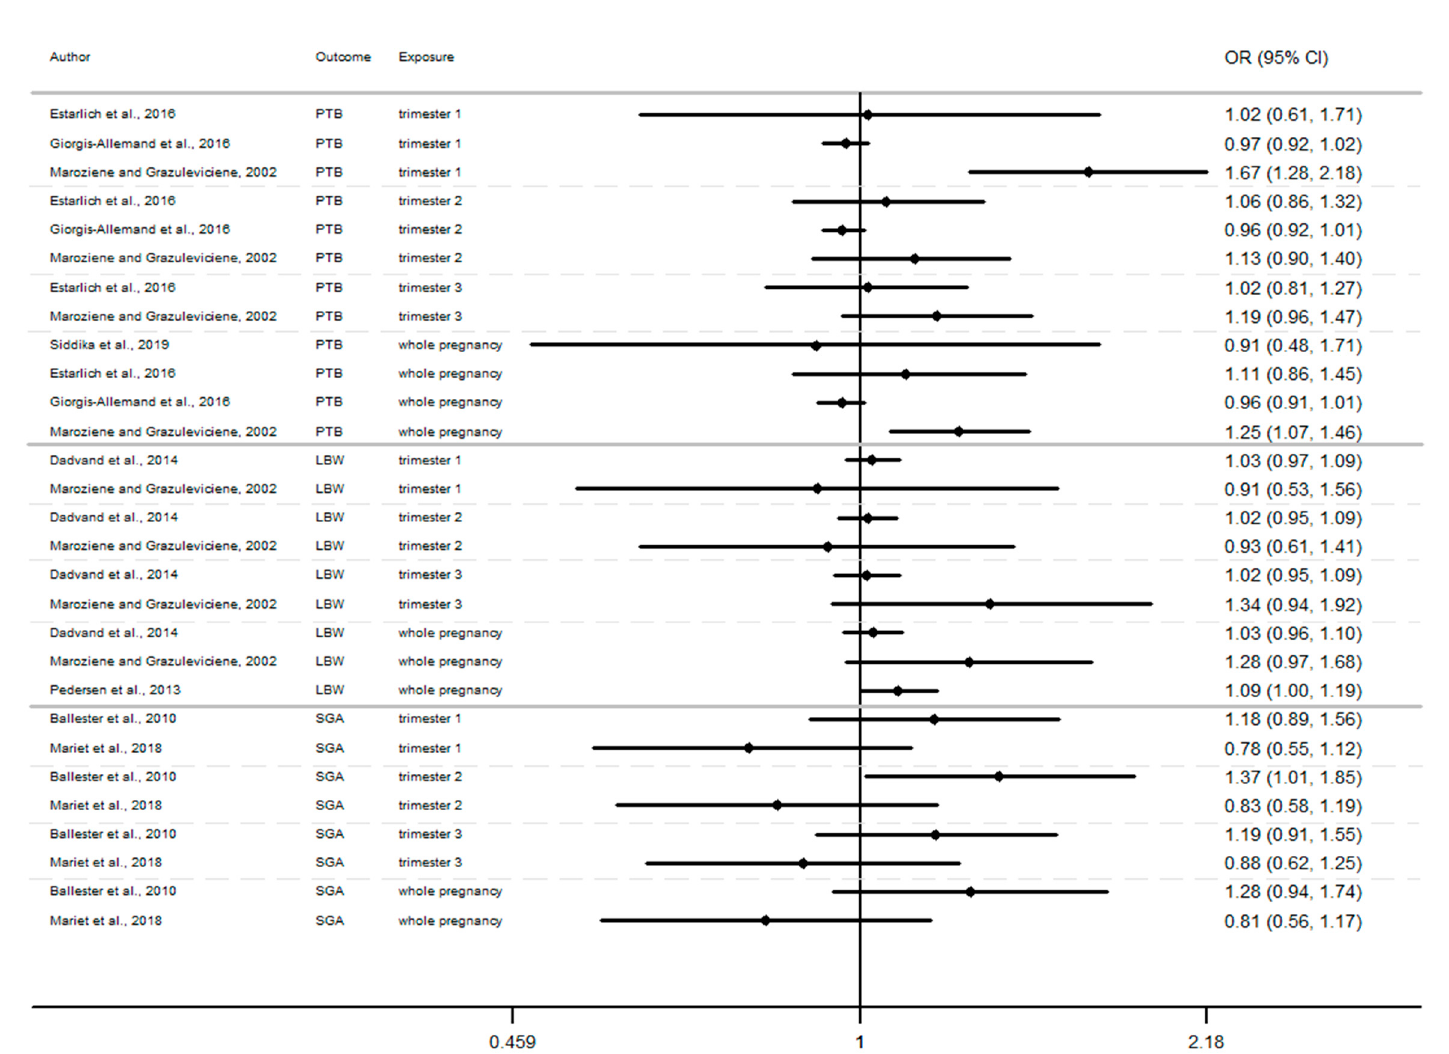
Figure 2. Risk of birth outcome for NO 2 exposure during different windows of exposure during pregnancy.